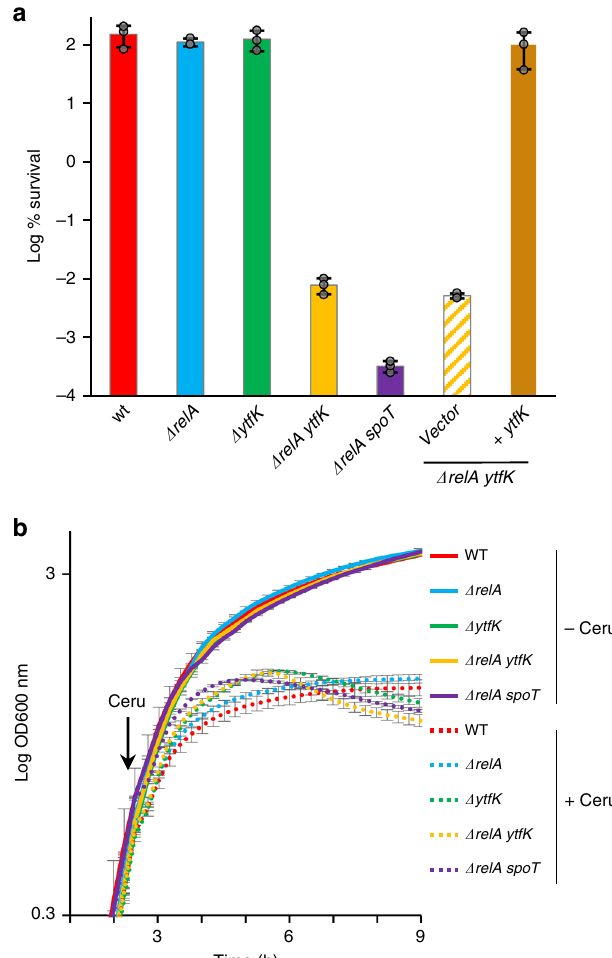
Fig. 4 YtfK contributes to antibiotic tolerance. a YtfK is required for cerulenin survival in absence of relA . Growing cells of MG1655 (WT) and isogenic deletion strains Δ relA , Δ ytfK , Δ relA ytfK, Δ relA spoT, and Δ relA ytfK harboring the pEG220 and the Δ relA ytfK harboring the pEG220- ytfK (with native promoter) were exposed to 500 µ g/mL of cerulenin for 4 h (see the Methods section). Percentage of survival (log scale) after 4 h is shown. Error bars indicate the SDs of averages of three independent experiments. b Growth curve of WT and isogenic deletion strains Δ relA , Δ ytfK, Δ relA ytfK and Δ relA spoT , in presence (dashed line) or absence (solid line) of cerulenin. Overnight culture were 1000 times diluted in LB, and growth was monitored at 600 nm using a microplate reader. At the indicated time, 250 µ g/ml of cerulenin was added. Error bars indicate the SDs of averages of three independent experiments. Source data are provided as a Source Data fi Fig. 5b, c). To further gain insight into the YtfK-SpoT interaction and its role in (p)ppGpp synthesis, we randomly mutagenized ytfK . One mutant that had proline 42 substituted with leucine (P42L), exhibited impaired interaction with SpoT (Fig. 5a). Both T18-YtfK and T18-YtfK P42L recombinant proteins were correctly expressed as shown by western blot with Anti-CyaA (Supple- mentary Fig. 5d). Overexpression of ytfK but not ytfK P42L (Supplementary Fig. 6a). This result predicts that the lack of interaction with SpoT abrogates the stimulatory effect of YtfK on (p)ppGpp accumulation. Indeed, it is the case. As judged by TLC analysis, ytfK P42L failed to promote (p)ppGpp synthesis when overexpressed in either WT or in Δ relA strains in contrast to the